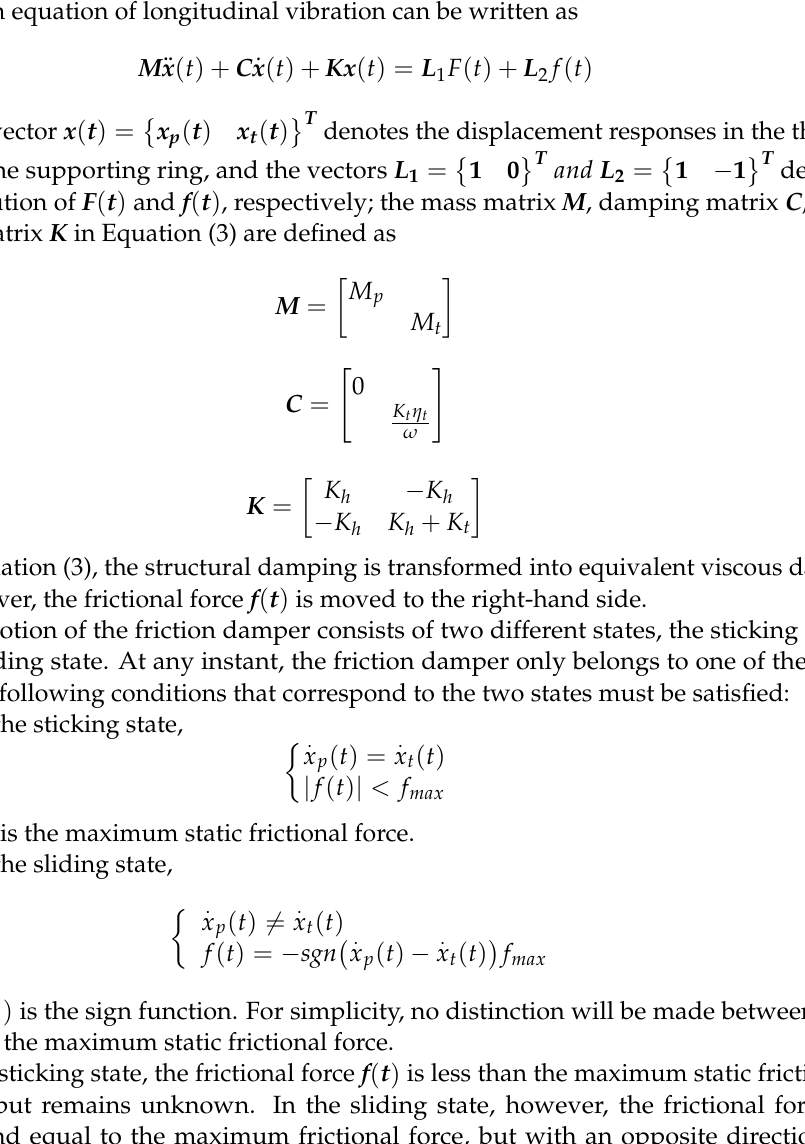
Figure 6. Two-degree-of-freedom model of friction damper.